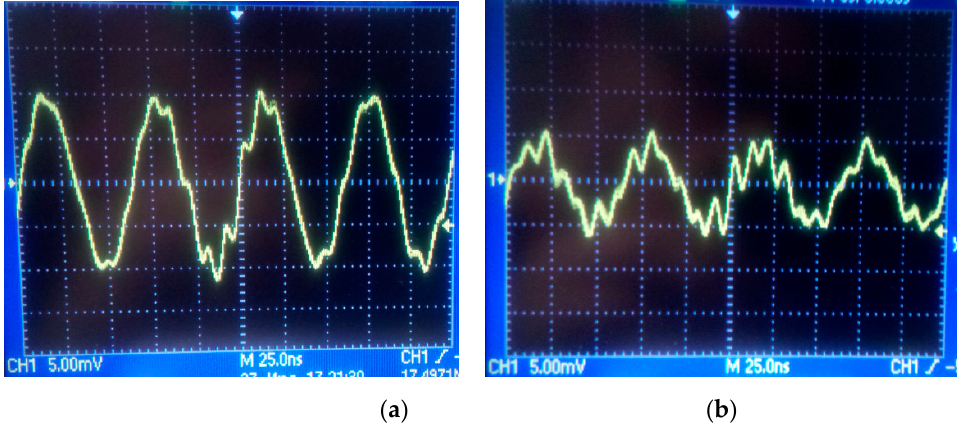
Figure 8. Oscillograms of the secondary channel of a SAW-based solid-state gyroscope: ( a ) spurious signal at the frequency of the SAW in the primary channel of 16.37 MHz; ( b ) spurious signal at the frequency of the SAW in the primary channel of 16.02 MHz.